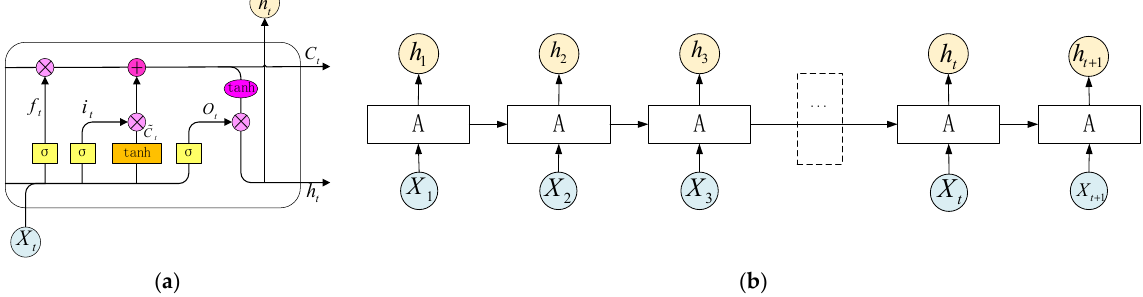
Figure 1. ( a ) Long short-term memory architecture; ( b ) typical structure of LSTM (1 layer). The single-layer and multi-layer LSTM models are shown separately in Figures 1b and 2.